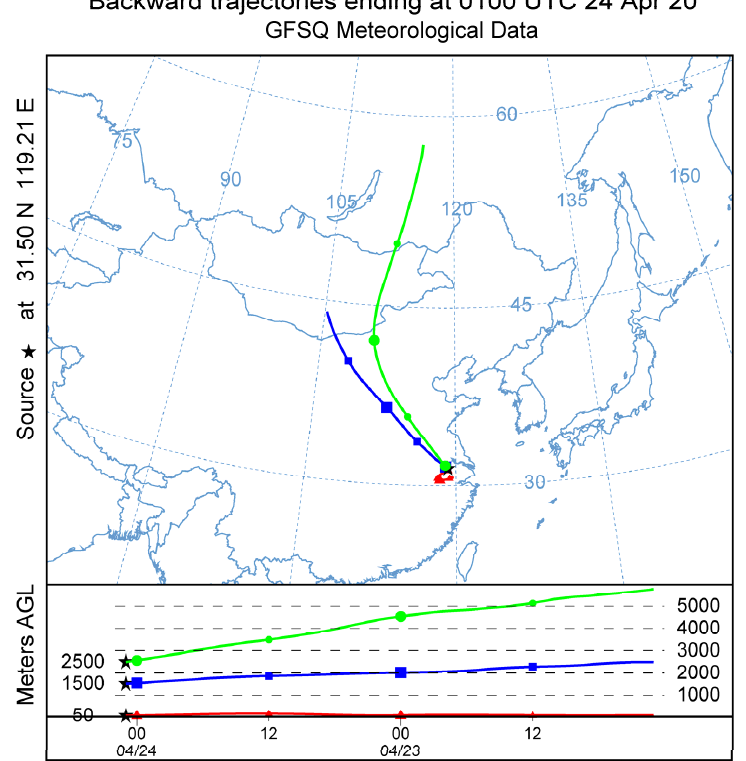
Figure A2. Backward trajectories arriving at the Shangxing validation site on 24 April 2019 at 50, 1500, and 3000 m levels, in red, blue, and green respectively.